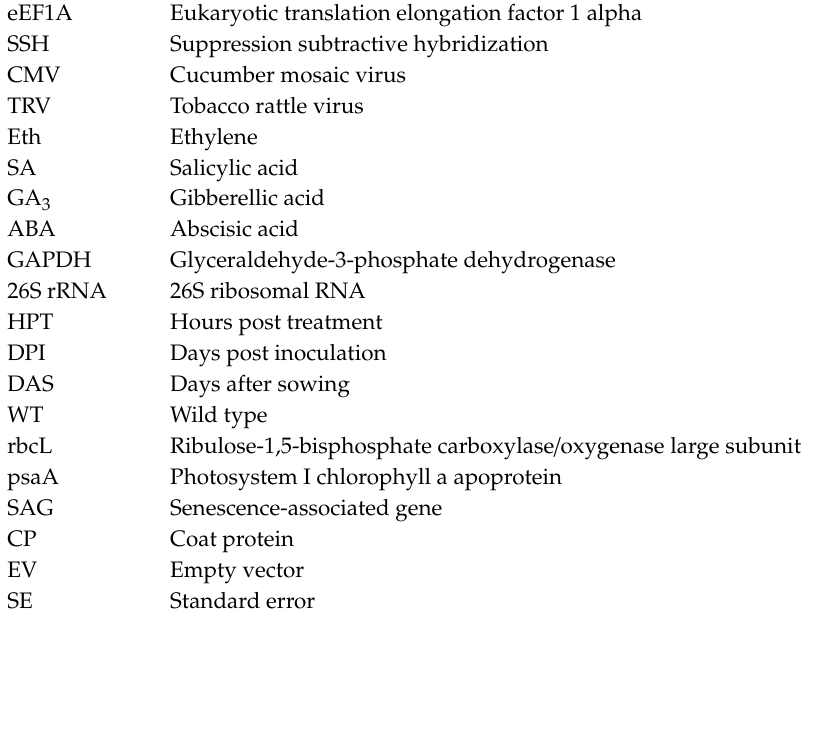
s1. Figure S1: Full-length cDNA and deduced amino acid sequences of LreEF1A4 , Figure S2: FASTA-formatted cDNA and deduced amino acid sequences of LreEF1A4 , Figure S3: Expression levels of genes related with photosynthesis and senescence in wild-type and LreEF1A4 -overexpressing transgenic petunia plants, Figure S4: Reduced accumulation of cucumber mosaic virus (CMV) and tobacco rattle virus (TRV) in PheEF1A -silenced petunia plants by VIGS, Figure S5: The impact of LreEF1A4 overexpression on cold tolerance of transgenic petunia plants, Table S1: Primers used for fragment amplification, semi-quantitative reverse transcription-polymerase chain reaction (RT-PCR), and quantitative real-time